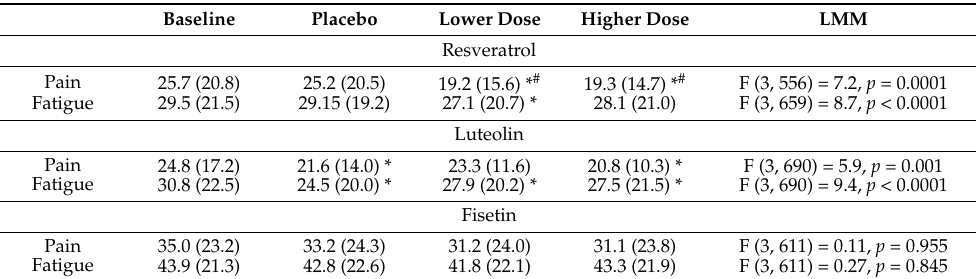
Table 1. Means (and standard deviations) and linear mixed models (LMM) results for the secondary outcomes of self-reported pain and fatigue. Results are presented separately for resveratrol ( n = 10), luteolin ( n = 11), and fisetin ( n = 11).